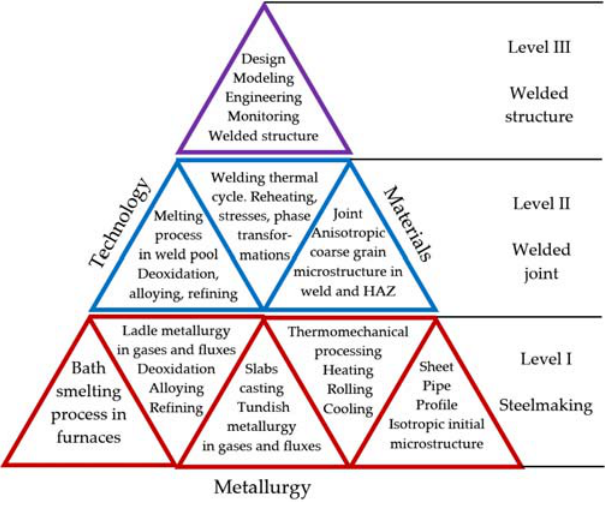
Figure 3. Multi-level system of processes for the manufacturing of welded structures.